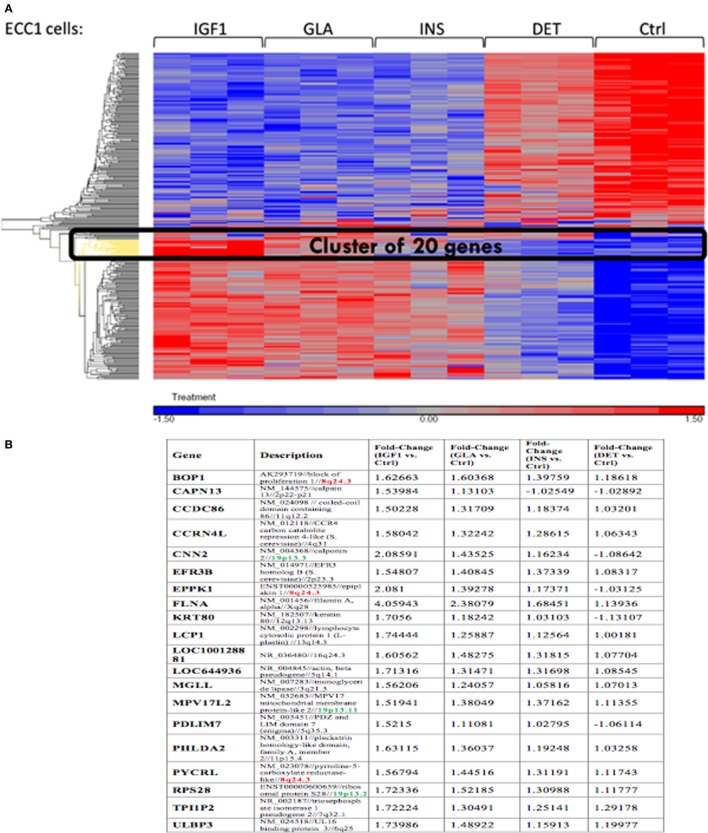
Features of differentially expressed genes in ECC-1 cells after ligands treatment. (A) Heatmap of 298 differentially expressed genes that were detected for all four treatments in ECC1 cells; (B) list of the 20 genes from the cluster marked in black in (A). Fold changes are indicated.